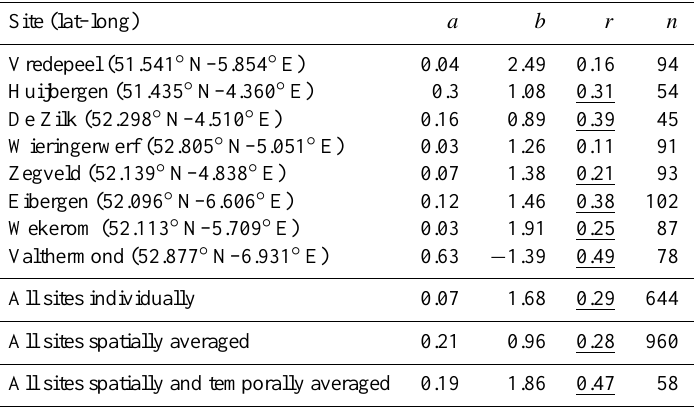
Table 2. Statistical analysis of the comparison of LML and IASI satellite surface concentrations in the Netherlands from 1 January 2008 to 31 December 2012. The spatial averaging (two bottom rows in the table) consists of considering the mean of all the ground-based observations and the mean of the satellite observations in the area covered by the LML network (considered here as the box 51.185–53.022 ◦ N and 4.01– 7.106 ◦ E). The temporal averaging (bottom row) consists in taking the mean of the observations (at the overpass time of the satellite) on a monthly basis. The slope and the intercept of the linear regression are indicated by a and b while the significant Pearson’s correlation coefficients ( r ) are underlined ( p value below 0.05); n corresponds to the number of points. Only IASI-derived values with a relative retrieval error below 100% have been taken into